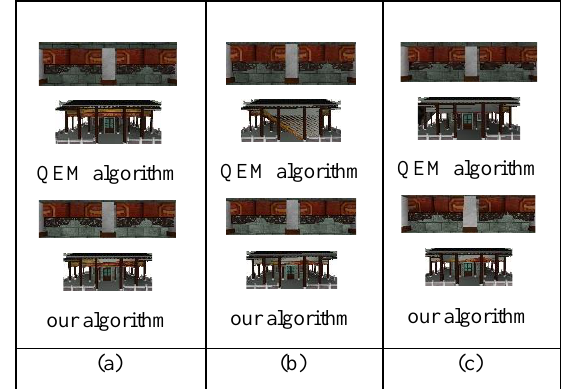
Figure 5 . Simplified results using QEM and our algorithm: